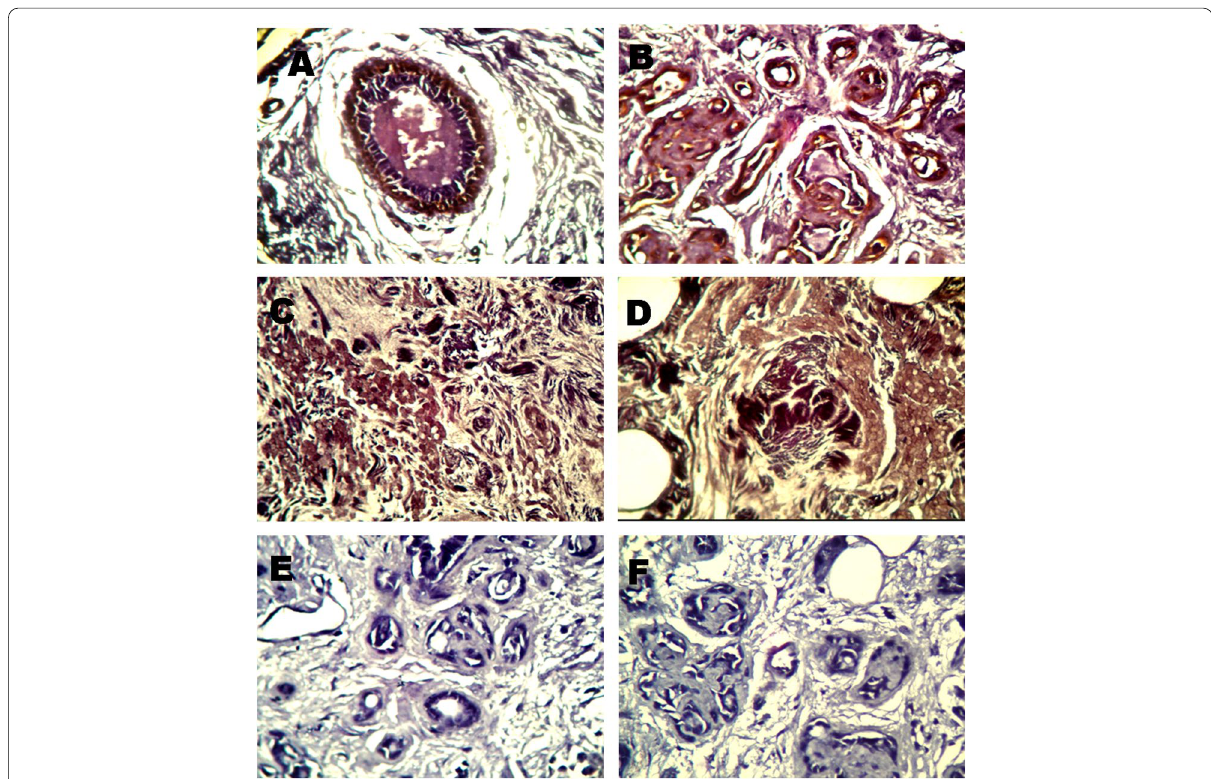
Fig. 8 The expression of a CK-18, b CK-19, c α-SMA, and d EpCAM in breast carcinoma tissue sections detected by